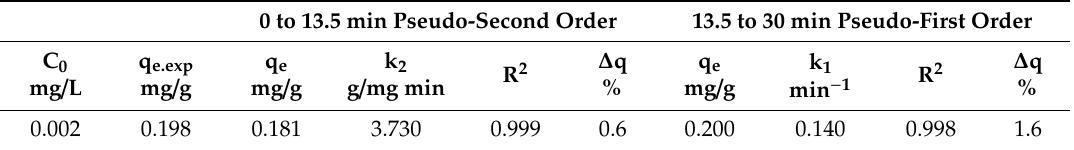
Table 5. Kinetic parameters of stepwise modeling applied to the adsorption of 2 µg/L of SMX per 10 mg/L of activated carbon.